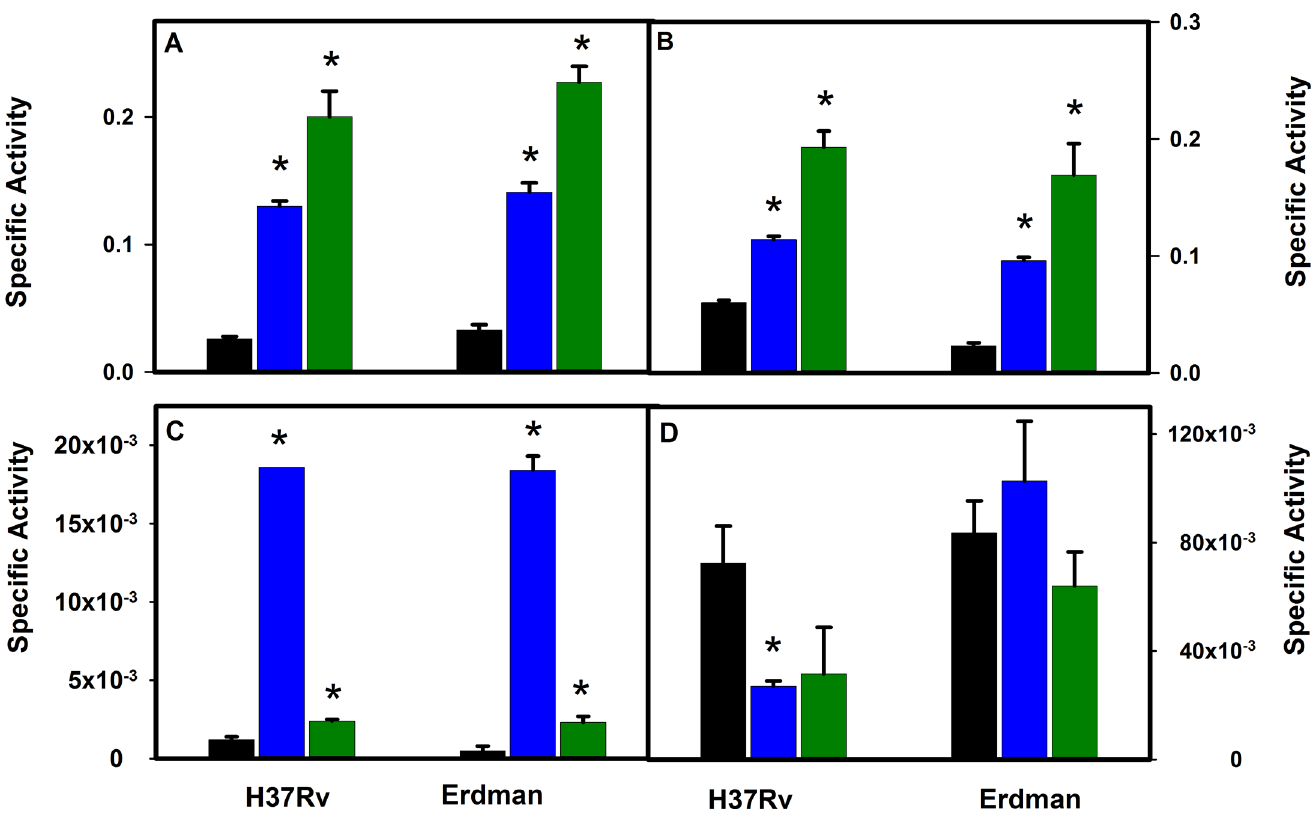
Fig 3. Enzyme Activities in M . tuberculosis H37Rv and Erdman. A: Glyoxylate reductive aminase activity. B: pyruvate reductive aminase activity. C: isocitrate lyase activity. D: malate synthase activity. Black bars are aerobic cultures, blue bars are NRP-1 and green bars are NRP-2. All units are μ moles/min/mg protein. The standard deviation is shown. Asterisks indicate statistical significance (p < 0.05) of the comparison with the aerobic samples.